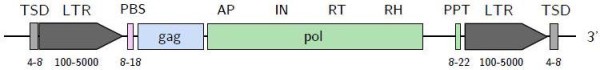
Structure of a typical long terminal repeat retrotransposon. Adapted from
[5]. AP:Aspartic protease; IN: integrase; LTR: long terminal repeat; PPT: polypurine tract; RH: RNase H; RT: reverse transcriptase; TSD: target site duplication. The numbers below the illustration denote typical lengths of the respective component. This example is of the copia-like superfamily, as it shows the IN-RT-RH domain order.